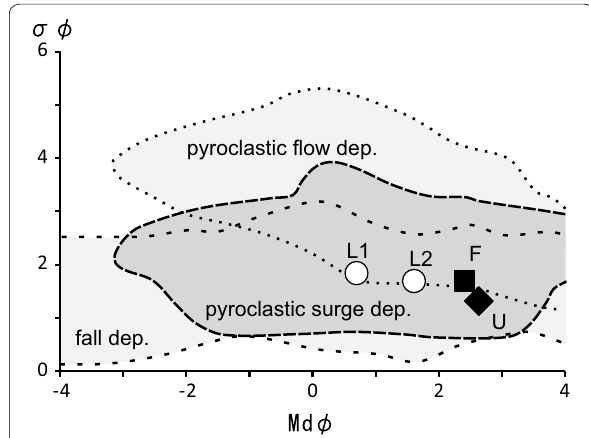
Fig. 7 Median diameter ( Mdφ ) versus sorting coefficient ( σφ ) for the PDC deposit collected from the Mukaehama area at the end of the northwestern lobe of the PDC. L1 and L2, lower part of Loc. 1; U, upper part of Loc. 1; F, fall deposit of Loc. 3. Sampling levels are shown in Fig. 6a, d. The areas for each deposit type are after Walker